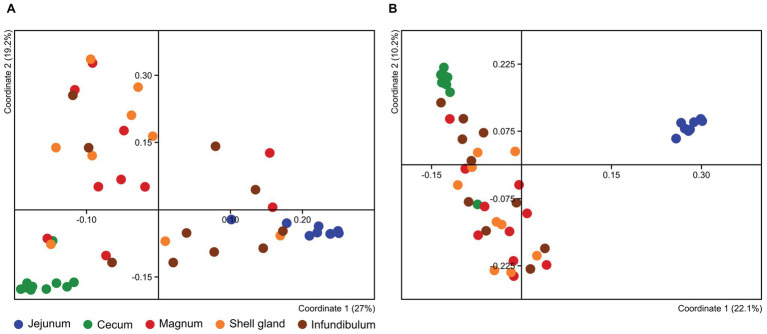
Taxonomic composition of all samples at the phylum level (A) and order level (B). The full legends are found in Supplementary Figures S2A,B.